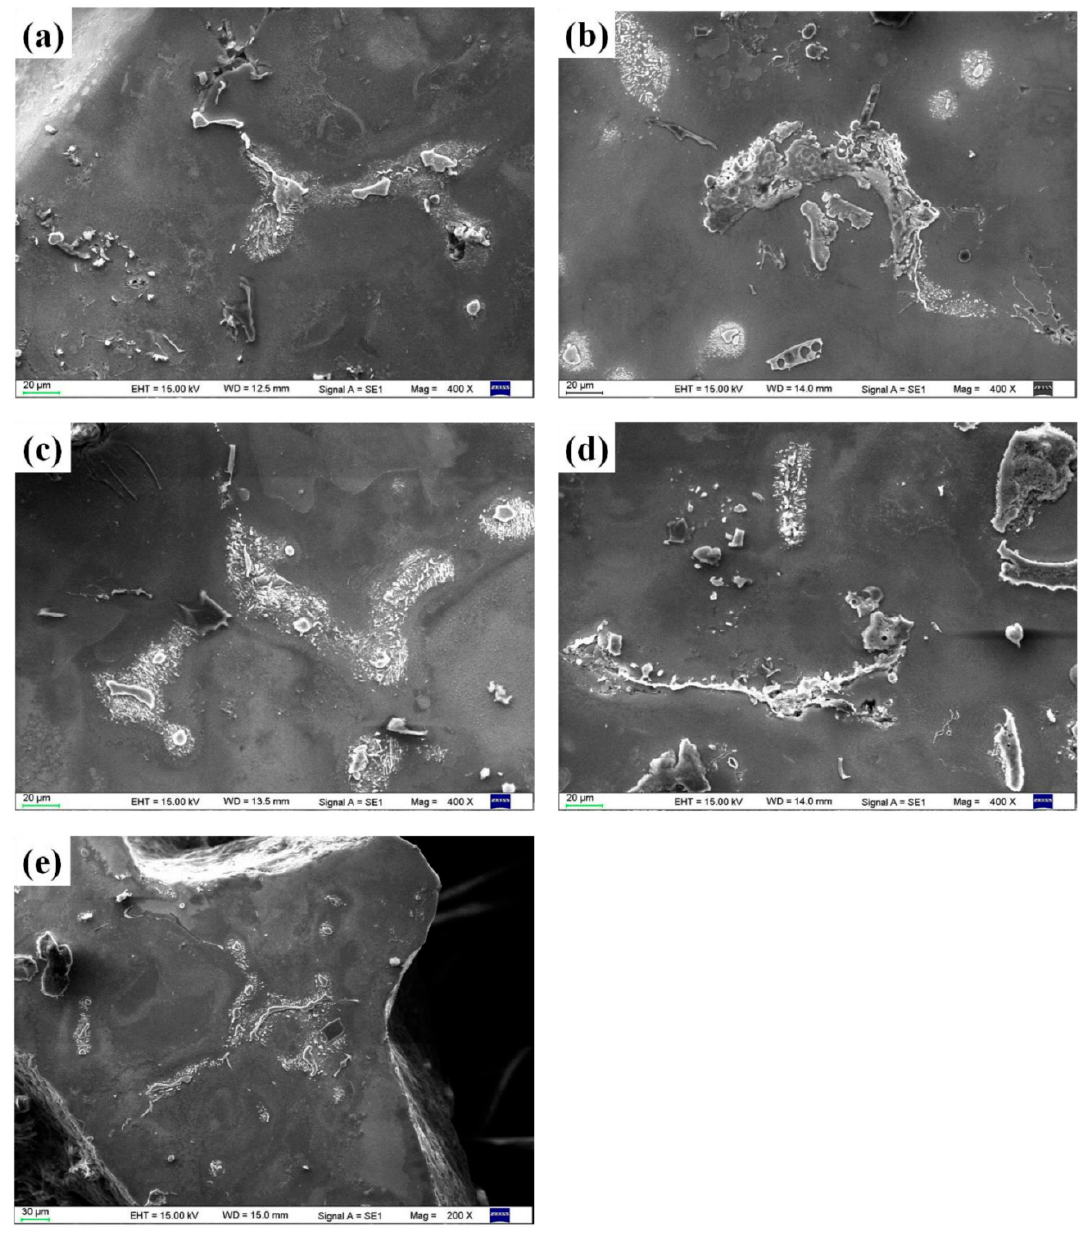
Figure 4. Morphology evolution of β -Mg 17 Al 12 in the composite foams heated at 320 °C for different holding times: ( a ) 1 h, ( b ) 2 h, ( c ) 4 h, ( d ) 6 h, and ( e ) 24 h.